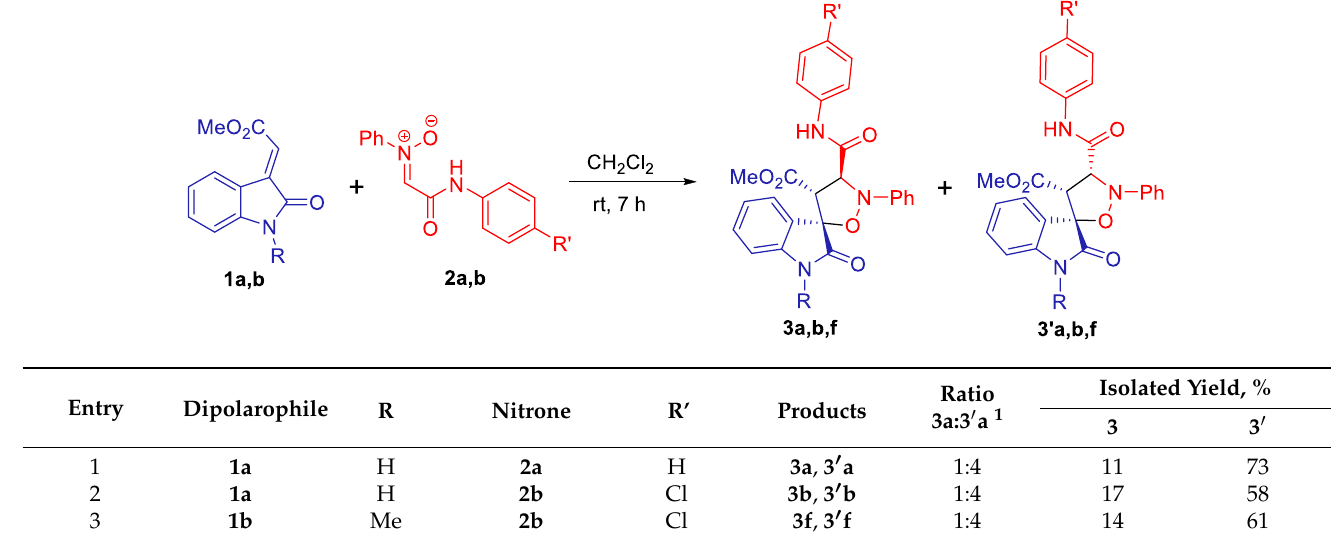
Table 3. Cycloaddition of 2-(2-oxoindoline-3-ylidene)acetates 1a,b with C -carbamoyl nitrones 2a,b at rt.